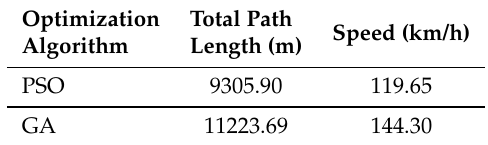
Table 2. Path length and average flight speed for each